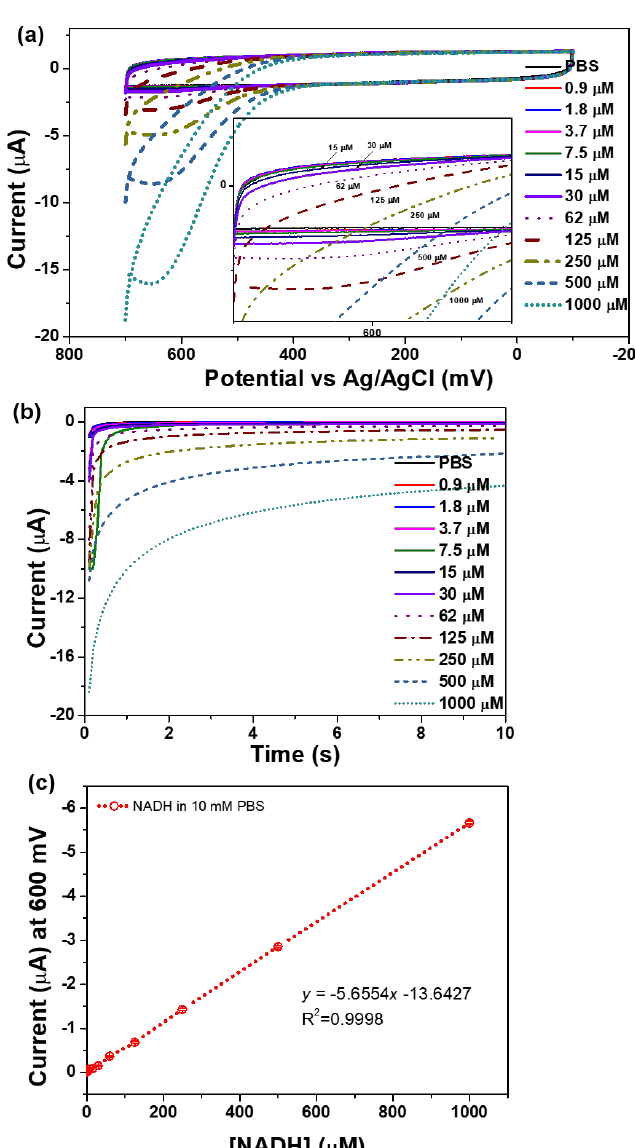
Figure 2. Typical electrochemical results for NADH in medium: ( a ) cyclic voltammogram; ( b ) chronoamperometry; and ( c ) calibration plot of NADH in medium ( n = 5). The viability obtained by the WST-1 assay depends on the number of live cells, as